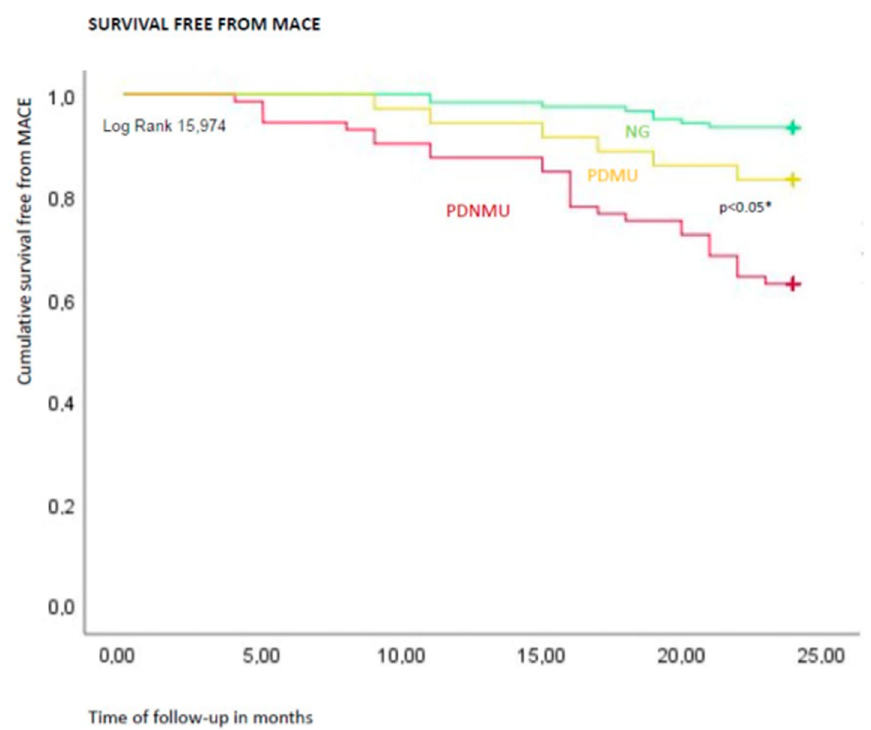
Figure 1. The Kaplan curves for freedom from Major Adverse Cardiac Events (MACE) at 2 years of follow-up in study cohorts. In this figure, the Kaplan curves for freedom from MACE at 2 years of follow-up (24 months) comparing pre-diabetics non-metformin users (PDNMU) versus normo- glycemics (NG), pre-diabetics metformin users (PDMU) versus NG, and PDNMU versus PDMU. The curves showed a significant difference regarding freedom from MACE at 2 years of follow-up (24 months) comparing PDNMU versus NG, PDMU versus NG, and PDNMU versus PDMU ( p < 0.05). The NG are represented in green color, the PDMU in yellow, and the PDNMU in red color. * Is for statistical significant ( p < 0.05).